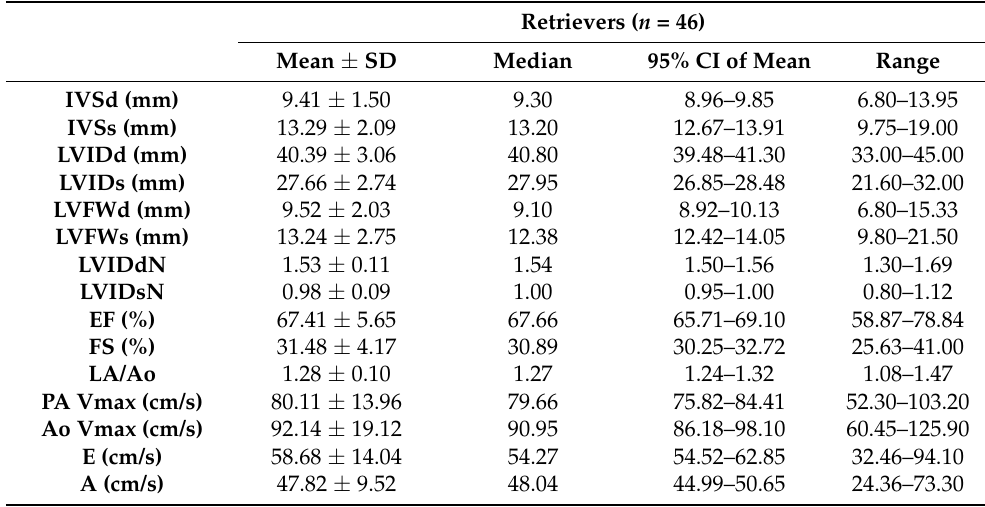
Table 2. Standard echocardiographic parameters of clinically healthy